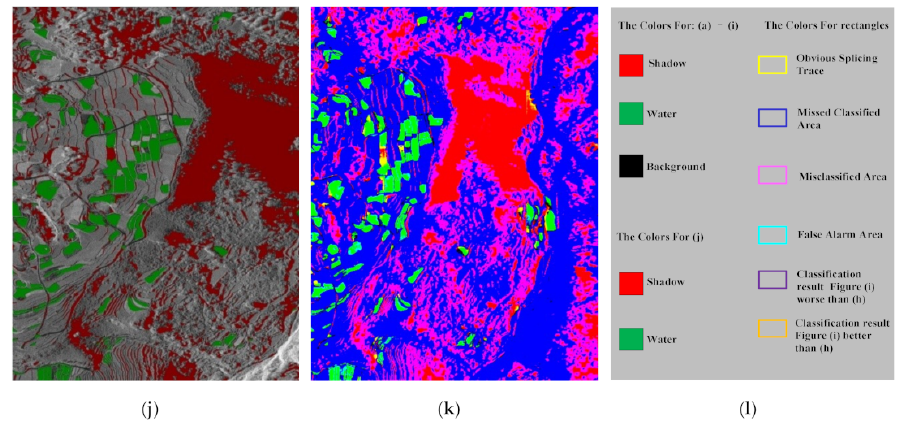
Figure 11. The extracted results for water and shadow from the SAR image. ( a ) The extracted results by RefineNet . ( b ) the extracted results by FCN-8s . ( c ) The extracted results by ResNet-101_FCN . ( d ) The extracted results by Large_Kernel_Matters . ( e ) The extracted result by Encoder_MFEF1 . ( f ) The extracted result by Lee_Encoder_MFEF1 . ( g ) The extracted result by GLGCM_Encoder_MFEF1 . ( h ) The extracted result by GLGCM_Encoder_MFEF1_2 . ( i ) The extracted result by MRDED . ( j ) The fusion map of SAR image and ( i ). ( k ) The visualization result of the results by MRDED . ( l ) Colors description for the classification results from ( a ) to ( j ). Table 4. The classification accuracy of the di ff erent frameworks. Framework